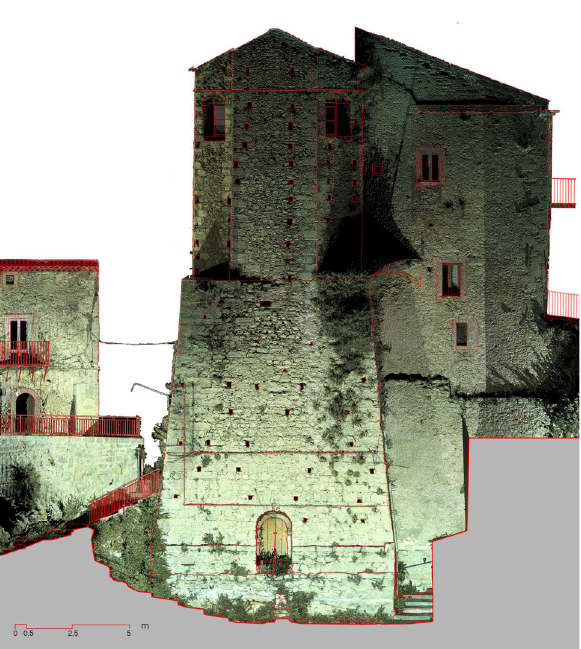
Fig. 4: Orthoprojection of the point cloud model. South-eastern front.